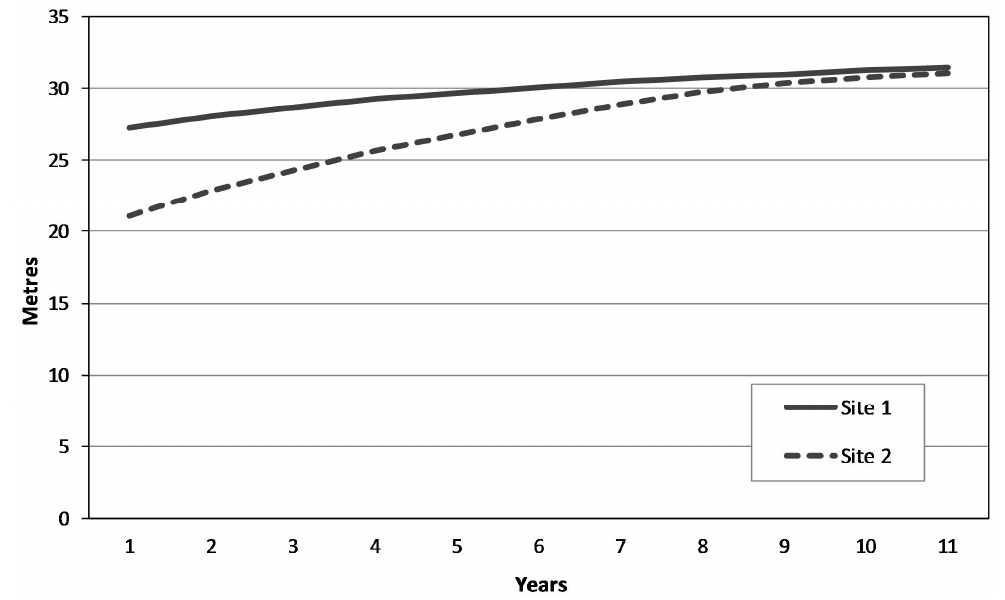
Figure 5. Naeslund height function for both study sites.